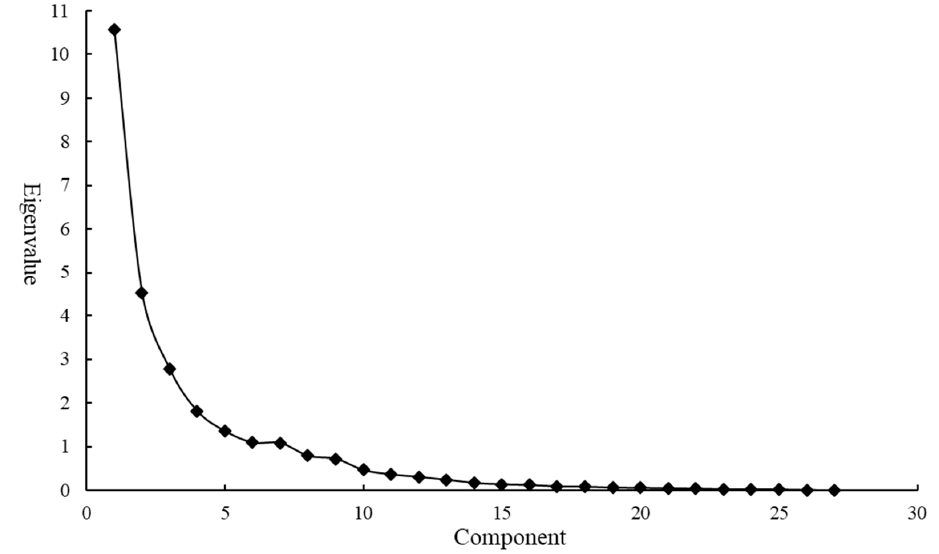
Figure 1. Lithotripsy diagram. Table 2. Rotated Component Matrix.